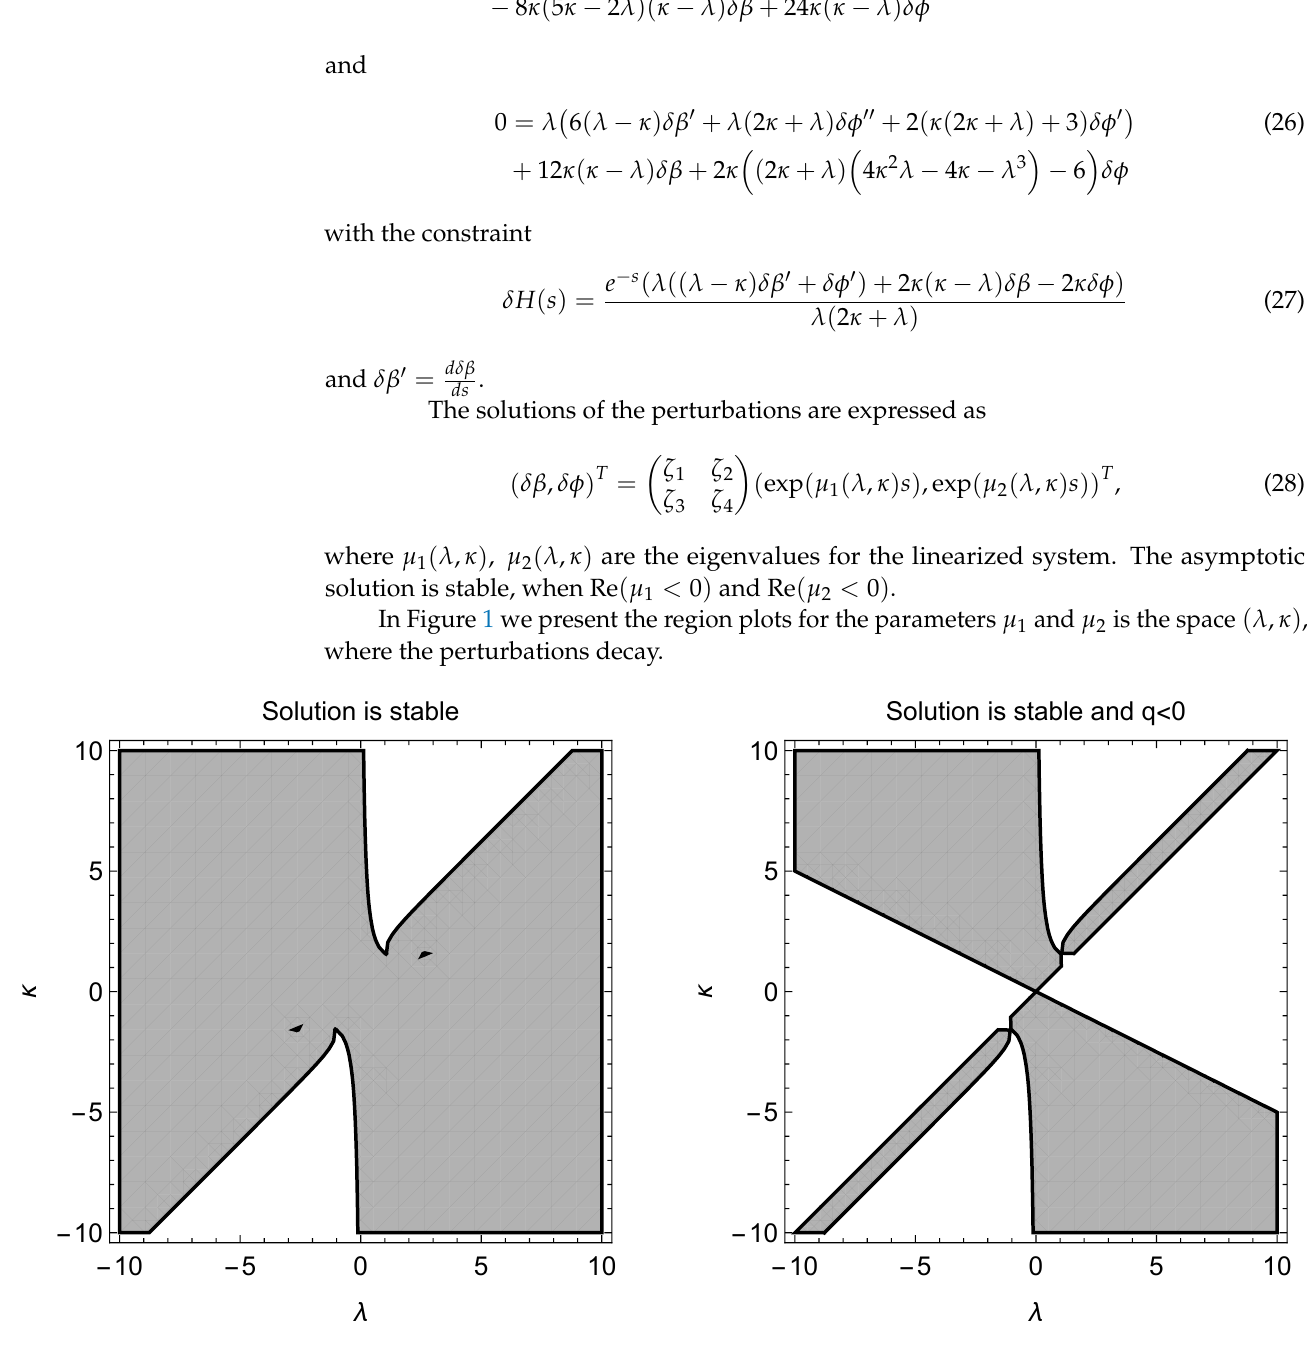
Figure 1. Region plot for the eigenvalues µ 1 ( λ , κ ) , µ 2 ( λ , κ ) , where the perturbations around the new anistropic solution decay ( left ), and the perturbations around the new anistropic solution decay and the new anisotropic solution describes an anisotopic inflationary universe ( right